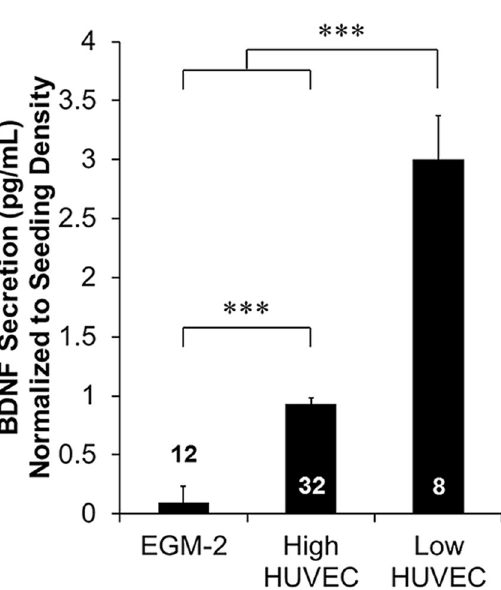
Figure 4. Quantification of HUVEC secretion of BDNF. HUVECs were seeded at high (10,000 cell/cm 2 ) or low (1,000 cell/cm 2 ) densities and cultured in parallel with DRG-HUVEC co-cultures and assayed for BDNF using ELISA kits, and normalized to their respective seeding densities. Both concentrations of HUVECs secreted measurable amounts of BDNF significantly higher than EGM-2 and low density seeding of HUVECs produced higher concentrations of BDNF per cell than high density seeding of HUVECs. Data are presented as mean ± standard error. *** (p < 0.001) and brackets indicate significance from other treatments as determined by one-way ANOVA with Holm-Sidak post hoc analysis (Well sample size for each group shown in bars from 2 independent